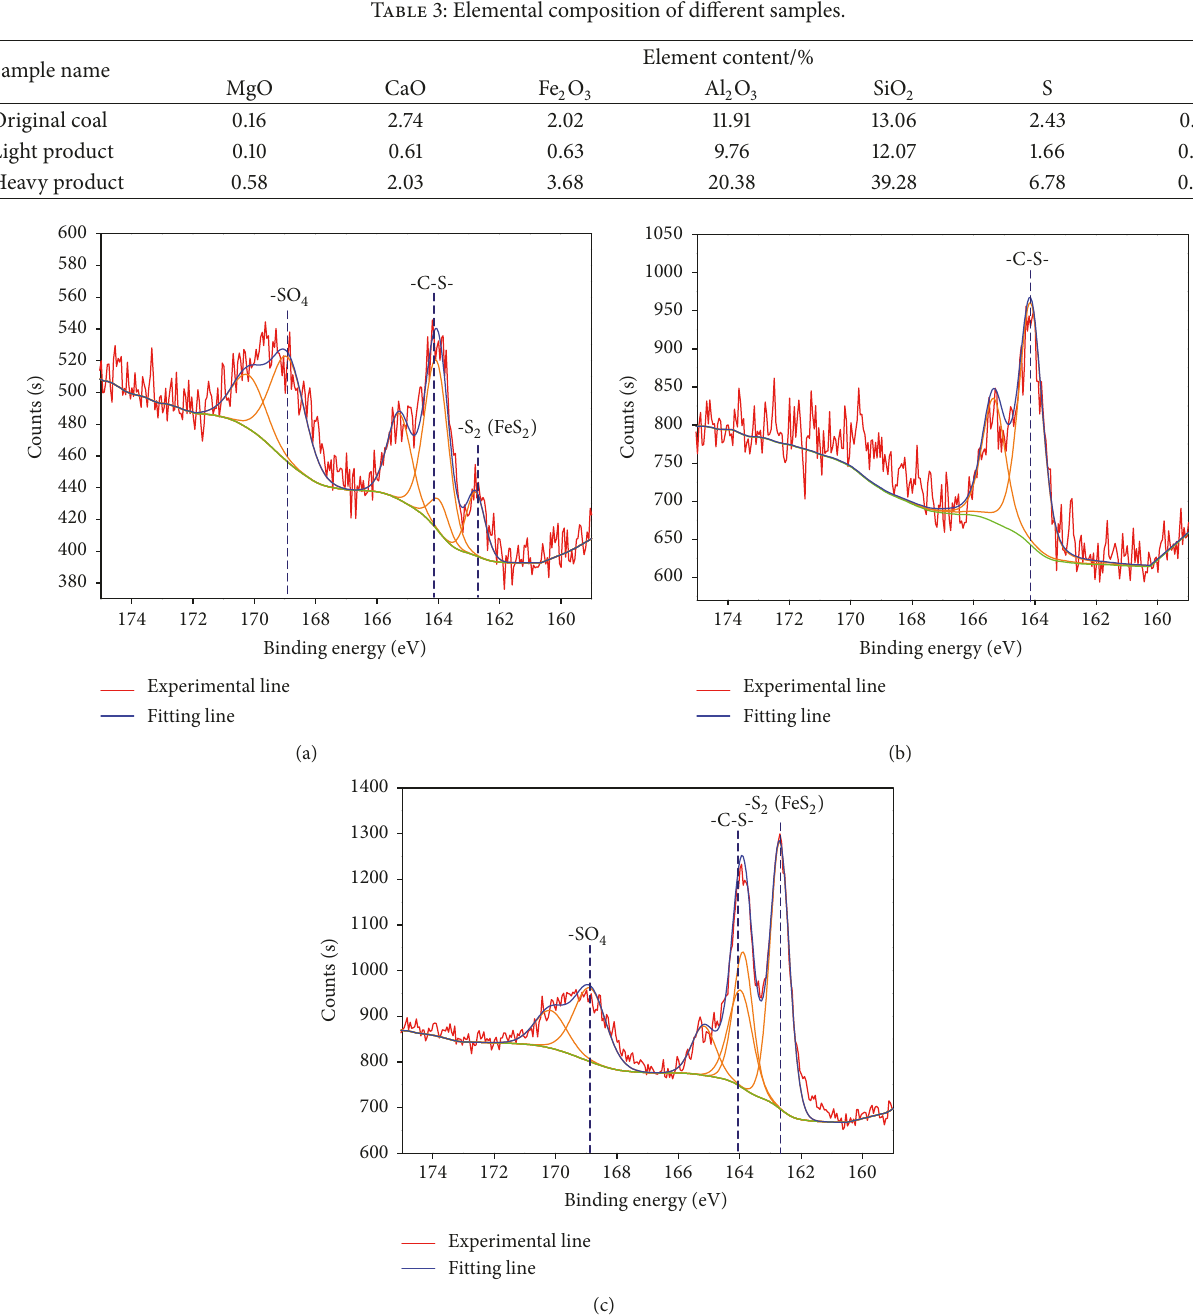
Figure 4: X-ray photoelectron spectroscopy spectra of the coal: (a) original coal; (b) light product; (c) heavy